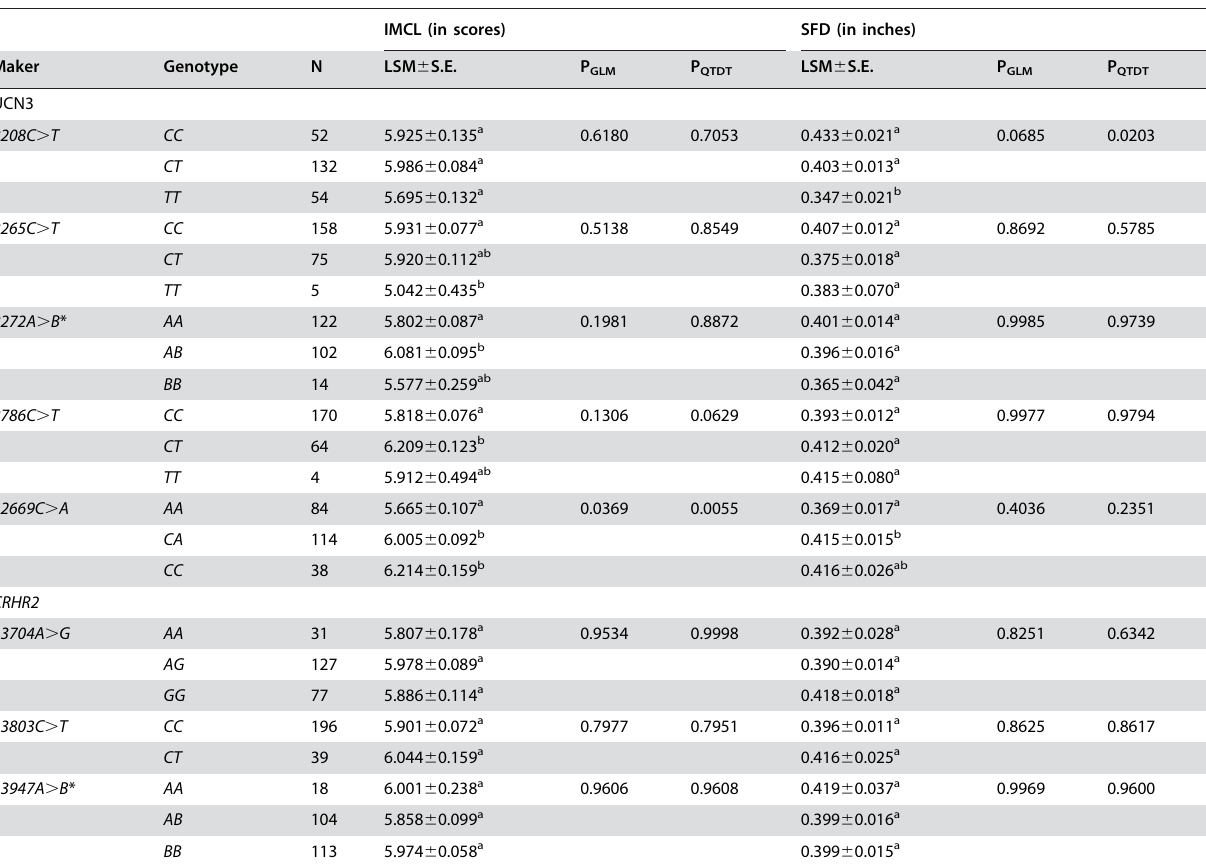
* See legends in Figure 1 and Figure 2.